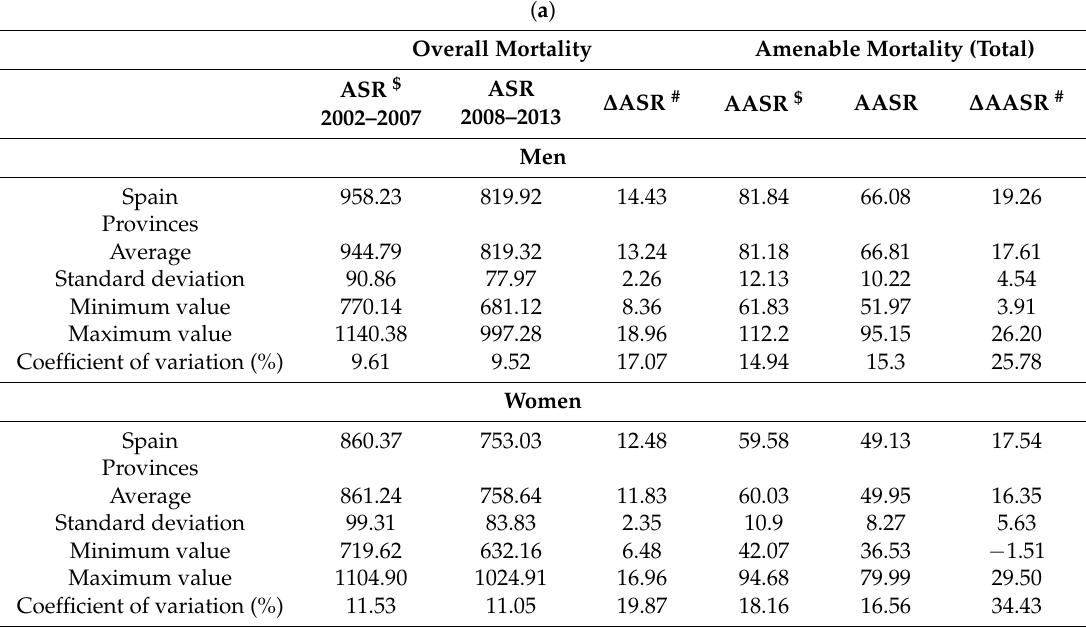
Table 2. Statistical description of standardised mortality rates and relative decreases of these between 2002–2007 and 2008–2013, by sex. ( a ) Statistical description of standardised mortality rates of these between 2002–2007 and 2008–2013, by sex. ( b ) Statistical description of relative decreases of these between 2002–2007 and 2008–2013, by